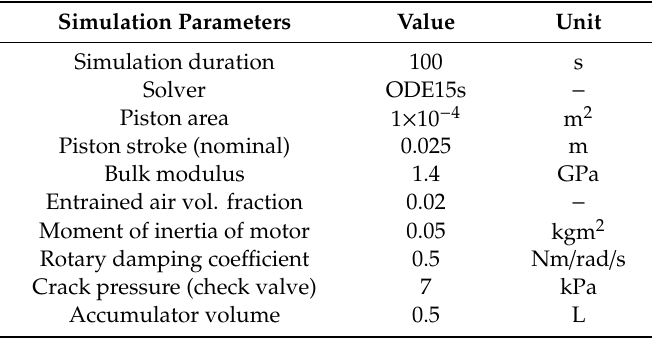
Table 2. Simulation parameters for the block